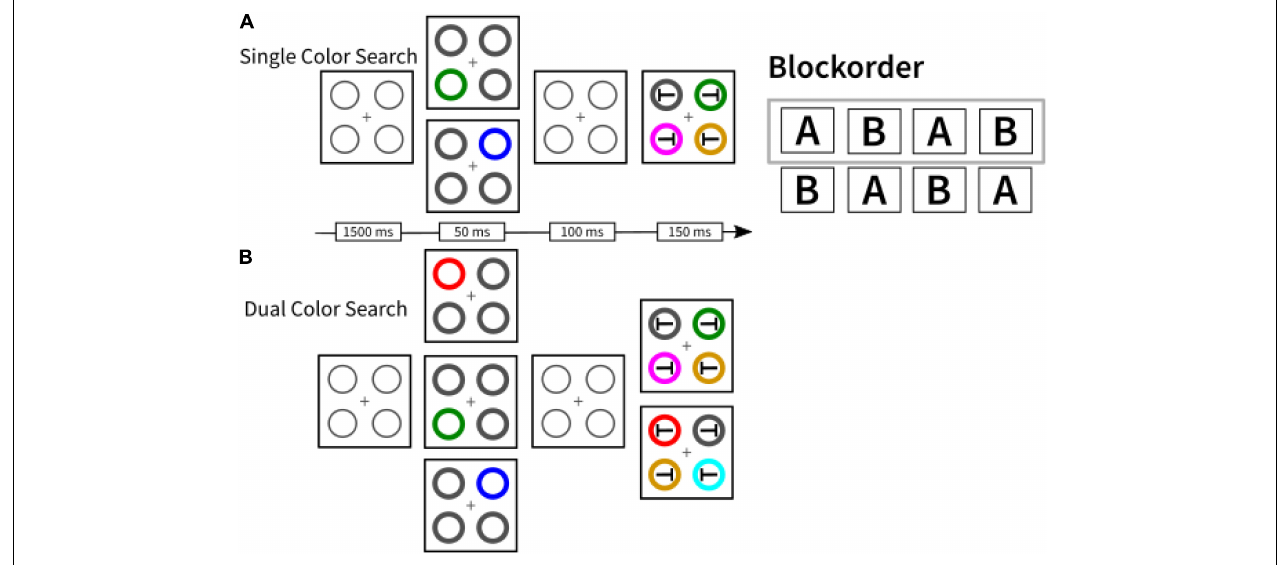
FIGURE 3 | A schematic depiction of the two search conditions used in Büsel et al. (2019). In single color search blocks (A) , participants were required to search for the same target feature throughout the whole block (here, for example, green). In dual color search blocks (B) , participants searched for a target that could randomly either be red or green. Block order was balanced across participants. For the analysis presented in Box 2 , we used data from participants in the A-B-A-B block order condition (framed